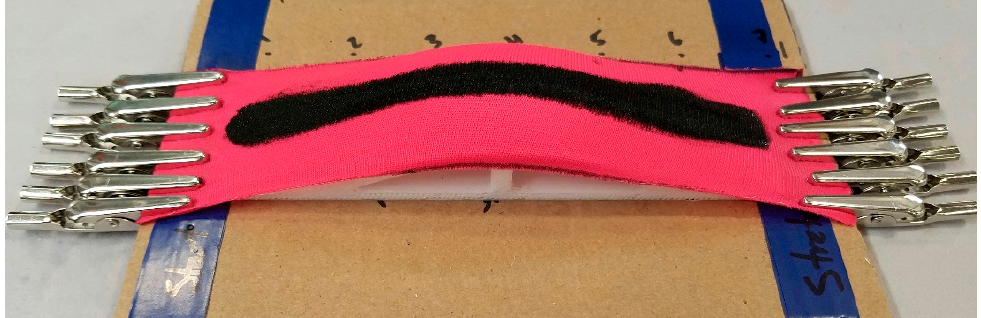
Figure 1. Conductive paint drying on stretched fabric.